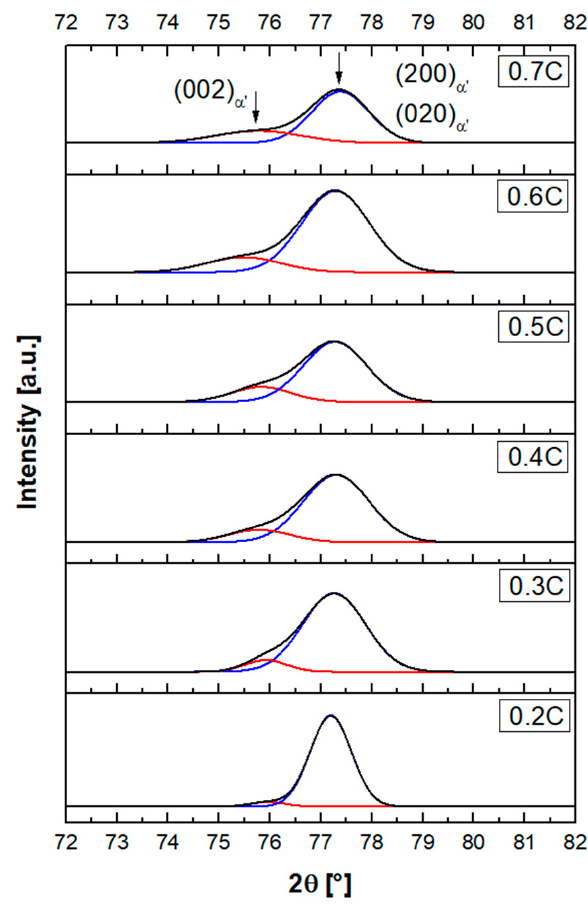
Figure 10. Martensite {002} α′ peak profile in the specimens obtained after quenching to 20 °C (black). Narrow lines in red and blue are the deconvoluted Gaussian fits.